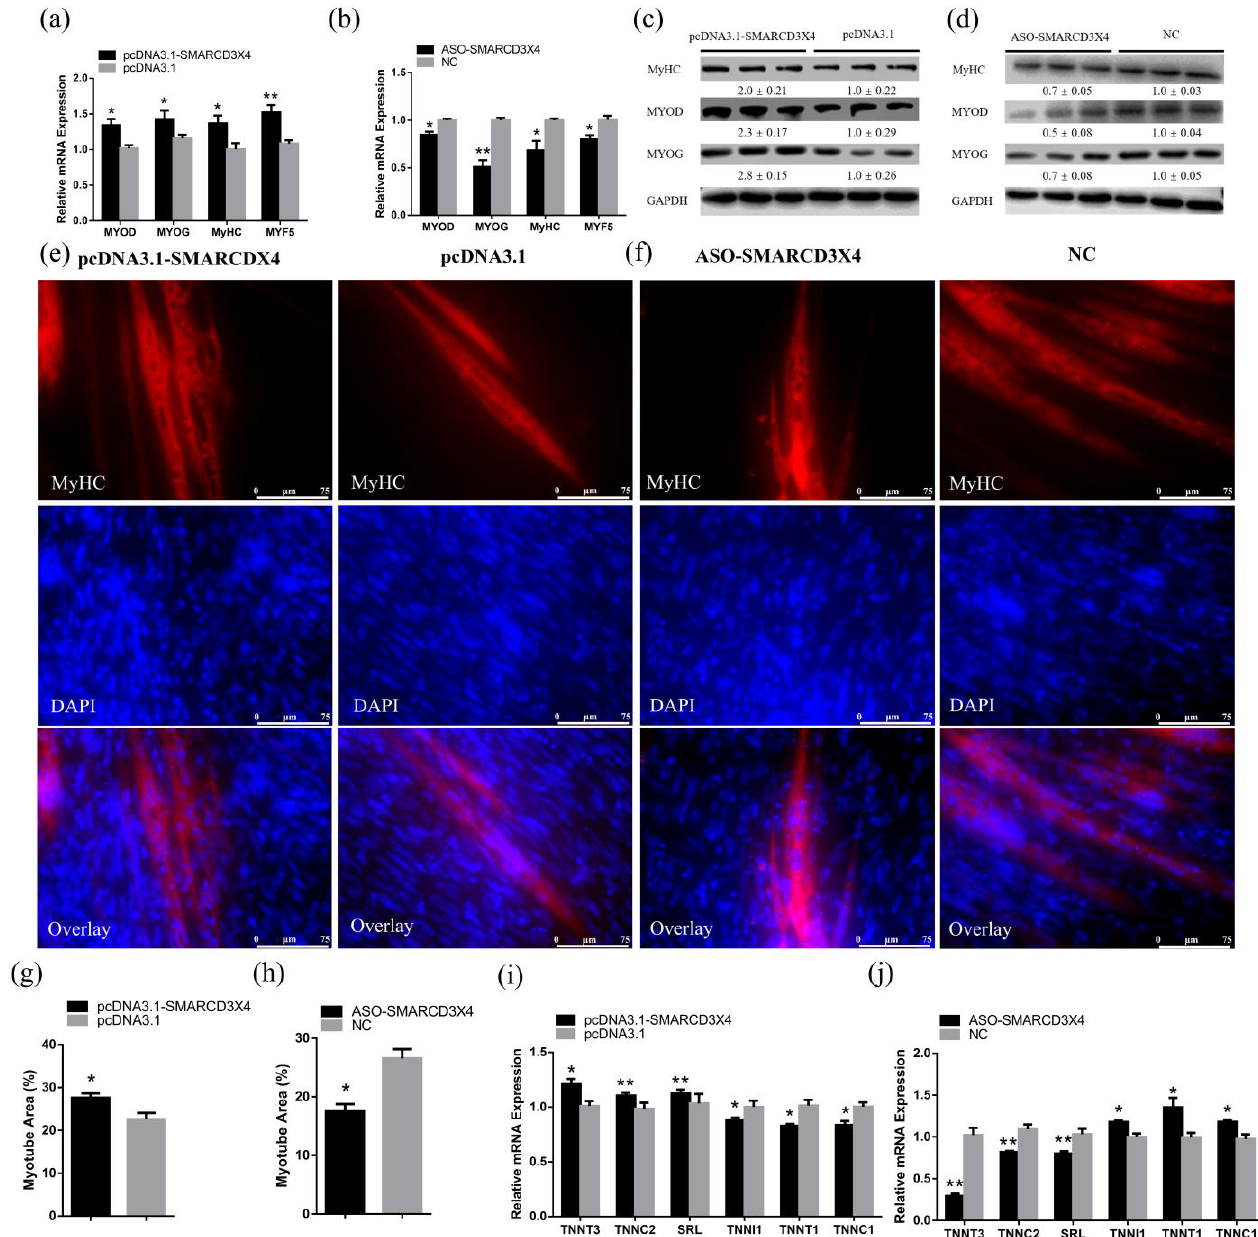
Figure 6. SMARCD3X4 promotes cell differentiation through the MYOD pathway and accelerates myofiber transformation during myoblast differentiation. ( a , b ) Relative mRNA levels of several cell differentiation marker genes after overexpression or knockdown of SMARCD3X4 ( n = 6). ( c , d ) Relative protein levels of several cell differentiation marker genes after overexpression or knockdown of SMARCD3X4 ( n = 3). The numbers shown below the bands are folds of band intensities relative to control. Band intensities were quantified by ImageJ and normalized to GAPDH. ( e , f ) MyHC immunostaining of CPMs with SMARCD3X4 overexpression or knockdown. ( g , h ) Myotube area (%) of CPMs transduced with SMARCD3X4 overexpression or knockdown in immunofluorescence assay ( n = 6). ( i , j ) Relative mRNA levels of several fast-twitch fiber- and slow-twitch fiber-related genes after overexpression or knockdown of SMARCD3X4 ( n = 6). All differentiation-related experiments are performed in CPMs after 3 days of differentiation induction using the differentiated medium. Data are expressed as a fold change relative to the control. Results are shown as mean ± SEM. Statistical significances of differences between means were assessed using an independent sample t test. * p < 0.05, ** p <